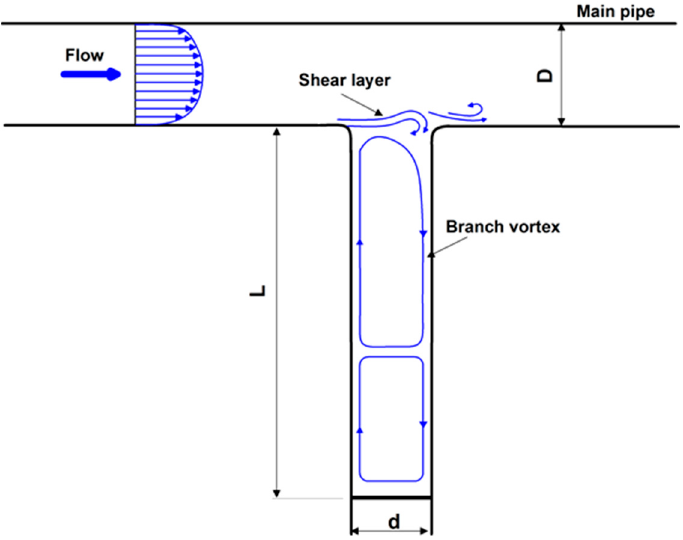
Figure 1. Principle of self-excited oscillations in closed side branches. D is the diameter of the main pipe, and L (d) is a length (diameter) of a side branch.